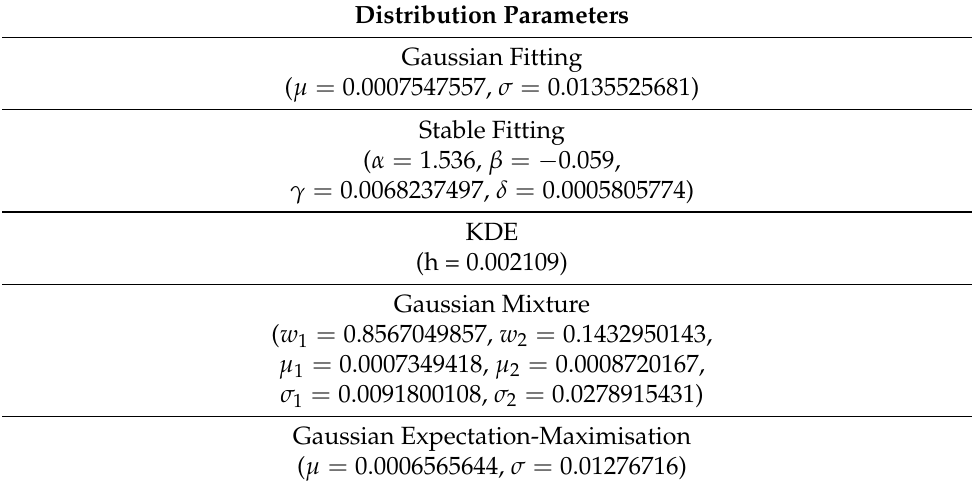
Table 1. Parameters of the distributions.